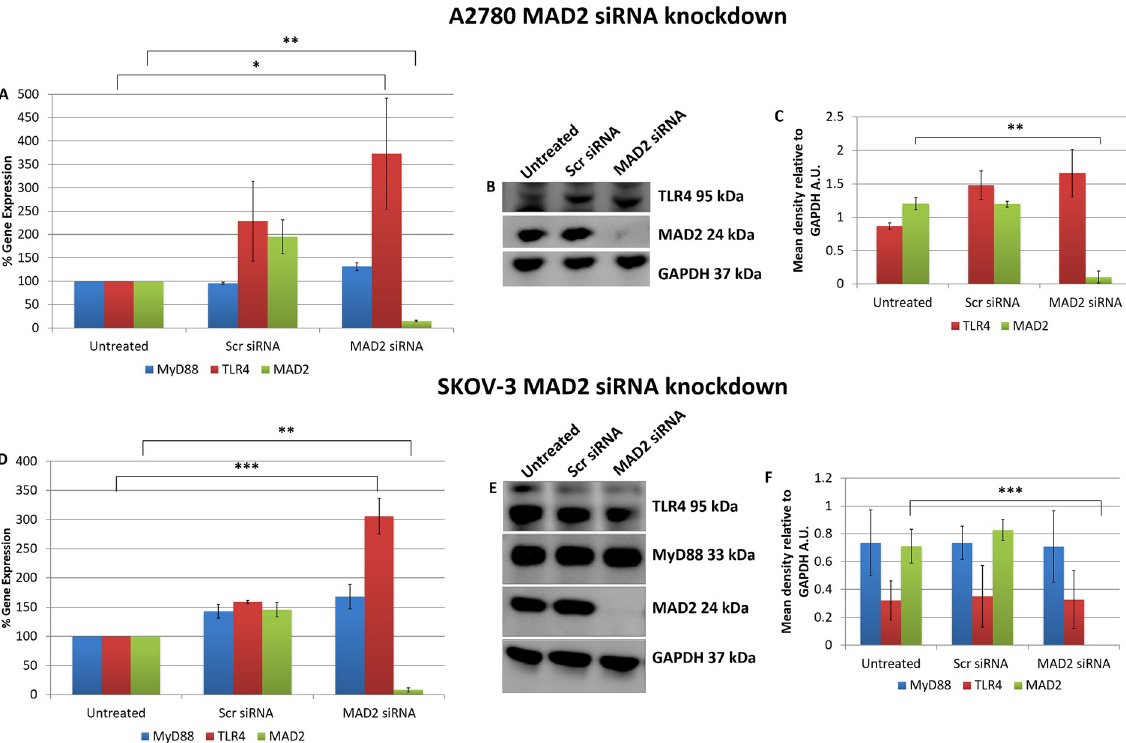
Fig 2. MAD2 is an inhibitor of TLR4 gene expression. MyD88, TLR4 and MAD2 gene expression levels in (A) A2780 and (D) SKOV-3 cells, 72 hours following transfection with siRNA targeting MAD2. Interestingly TLR4 gene expression, but not that of its adaptor molecule MyD88, was increased 3-fold following siRNA knockdown of MAD2 for 72 hours in both cell lines. (B) Western blot and (C) densitometry analysis of protein lysates harvested from A2780 cells following knockdown of MAD2 revealed however that suppression of MAD2 had no impact on TLR4 or MyD88 protein expression. Similarly, western blot (E) and densitometric analysis (F) in SKOV-3 cells found no significant increase in TLR4 protein expression post knockdown of MAD2. Results are expressed as mean +/-SD, n = 3; � p < 0.05, �� p < 0.01, ��� p < 0.001 (Student’s t-test). Densitometry results are expressed in arbitrary units (A.U) normalised to GAPDH. Note :- Blots are cropped from original images available in the S1 Raw Images.